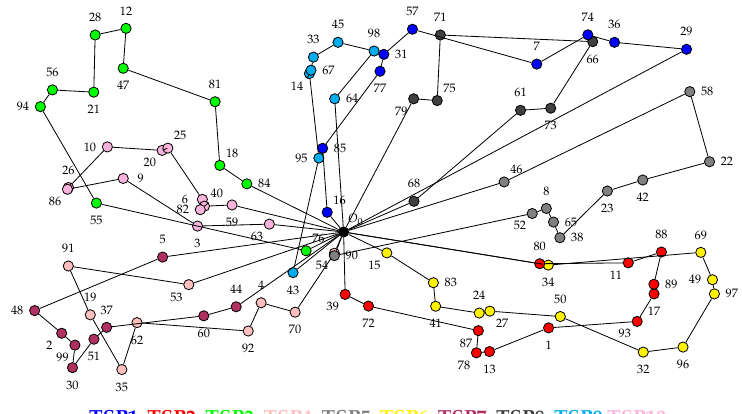
Figure 10. Tours for